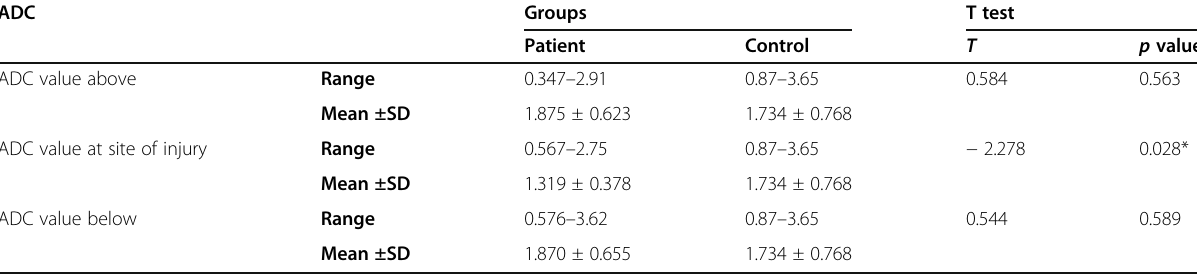
Table 4 Comparison of ADC parameter between patients and control group ADC